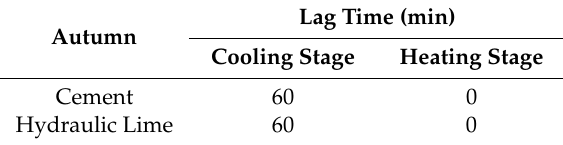
Table 5. Lag time between the maximum and minimum temperatures in autumn climate. Lag Time (min) Autumn Cooling Stage Heating Stage